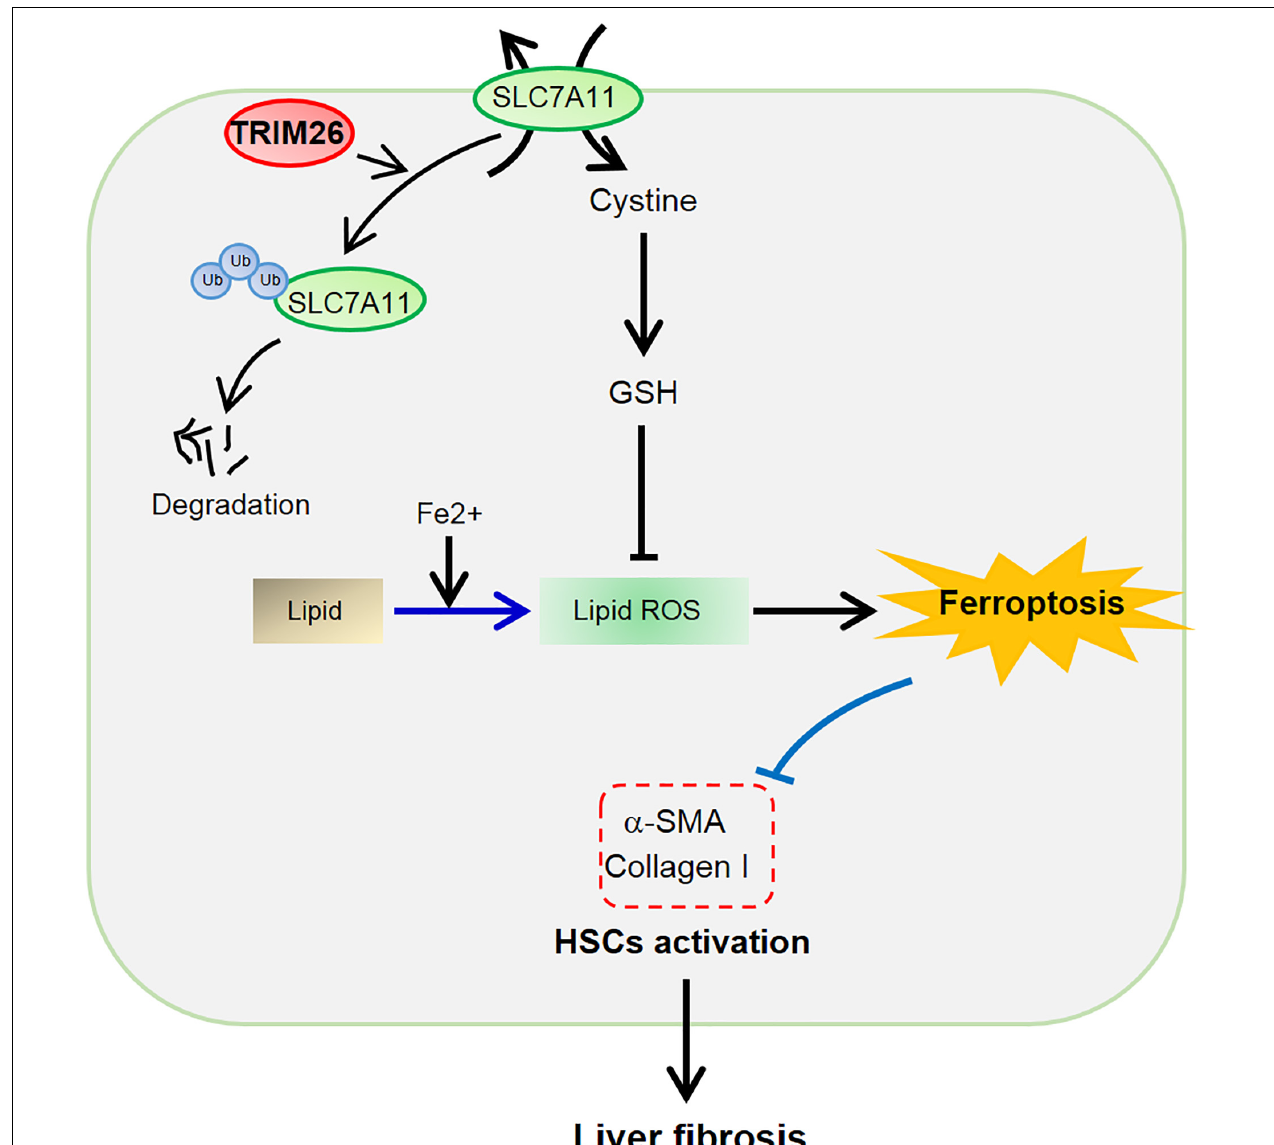
FIGURE 7 | Schematic of the TRIM26-involved regulation of HSCs ferroptosis and activation during liver fibrosis.